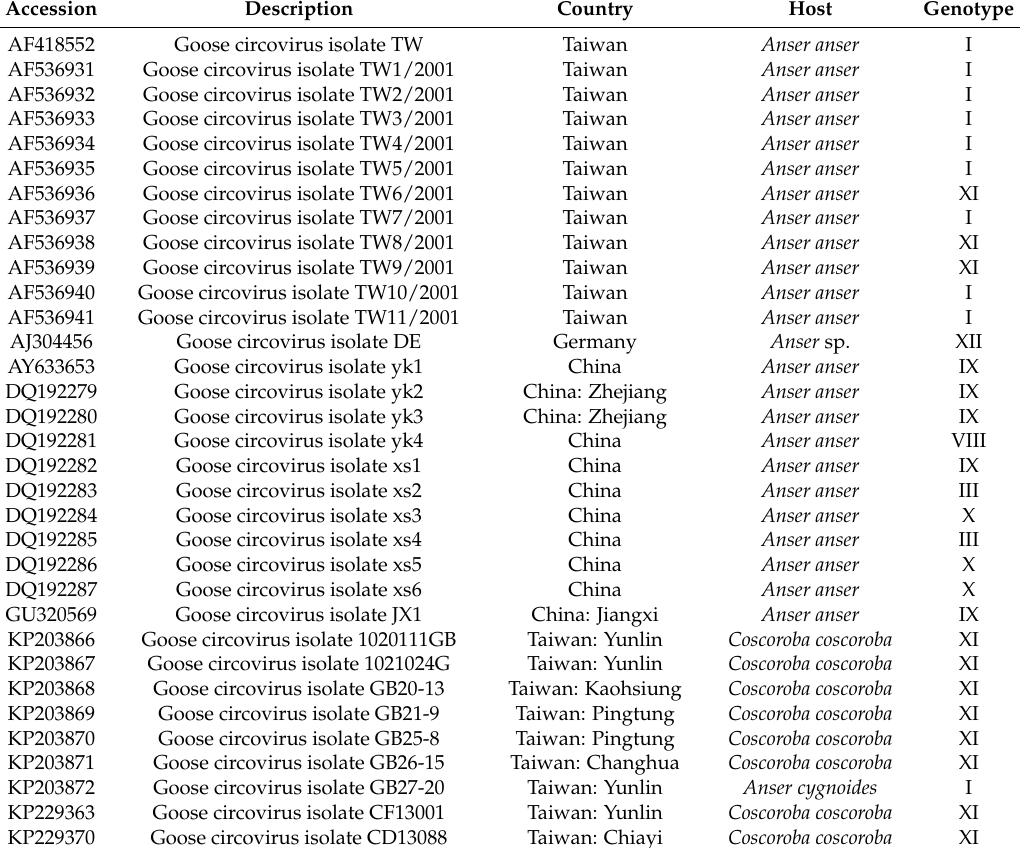
Table 2. Details of 63 Goose circovirus (GoCV) genome sequences used in this study. GoCV